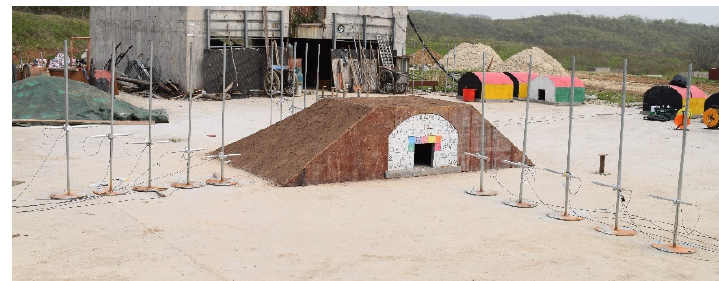
Figure 4. Arrangement of sensors.